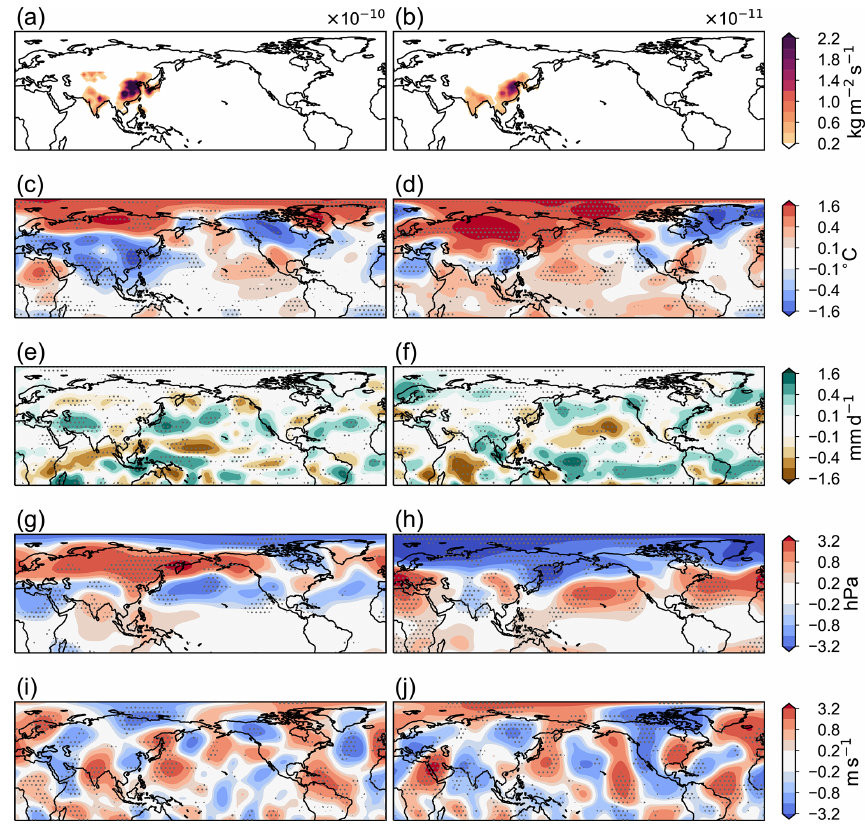
Figure 7. Spatial patterns of PDRMIP anomalies in (a, b) emissions, (c, d) near-surface air temperature, (e, f) precipitation rate, (g, h) sea- level pressure and (i, j) 200hPa meridional wind speed for coupled SULx10a (left) and BCx10a (right) during JF of year 1. Stippling indicates where at least 85% of the models agree on the sign of